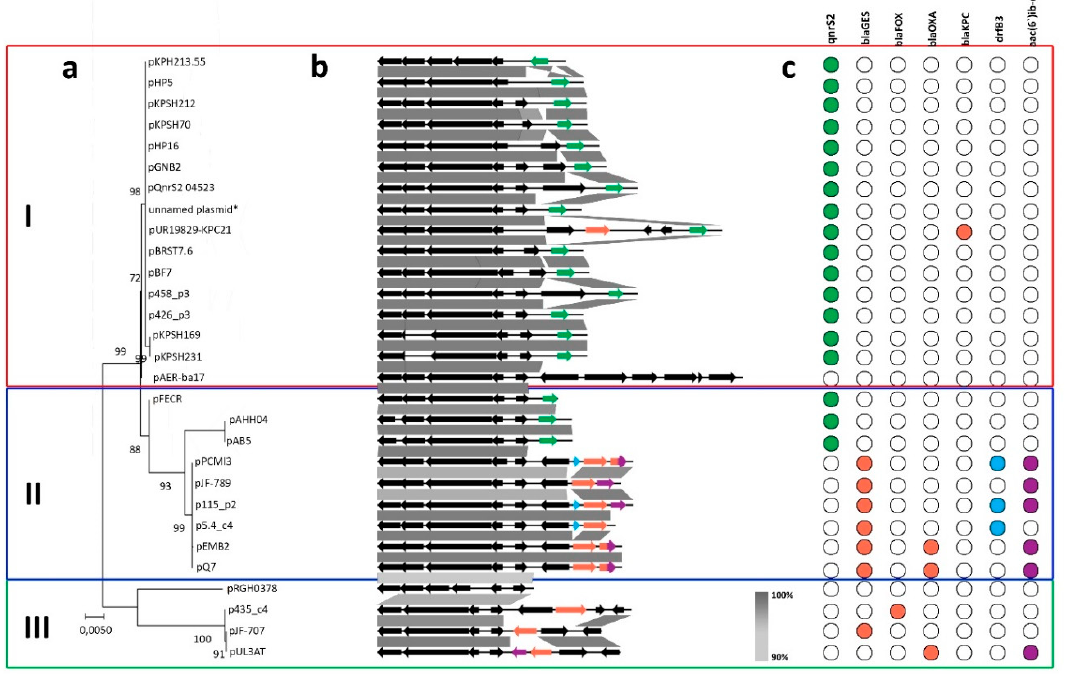
Figure 2. Comparative analyses of IncQ-3 plasmids: ( a ) Phylogenetic tree based on core genes of IncQ-3 replicons; ( b ) linear maps showing the schematic genetic structure of the circular IncQ-3 plasmids (retrieved from the NCBI database on 22 March 2020). The gray-shaded areas connect DNA regions of at least 90% sequence identity; ARGs were colored as on panel c. ( c ) ARGs carried by IncQ-3 plasmids conferring resistance to: Fluoroquinolones (green), β -lactams (orange), trimethoprim (blue), and aminoglycosides (violet).